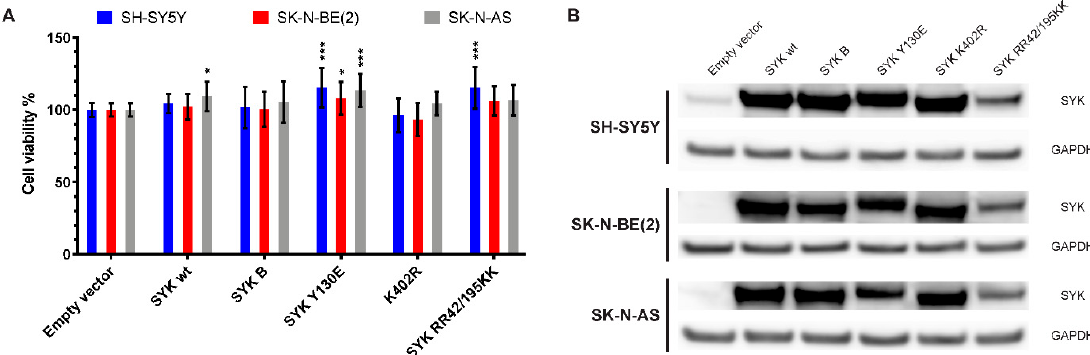
Figure 8. Transfection with an active SYK variant increases the cell viability of neuroblastoma cells independent of endogenous SYK levels. Cells were transfected with expression plasmids encoding different SYK variants and the cell viability was measured after 48 h by MTT assay ( A ). The empty vector control was set as 100% viable cells. Data are presented as mean ± SD from six independent experiments. Statistical comparisons were made using two-way ANOVA and a difference was observed between the SYK variants and between cell lines p < 0.001. The Dunnett’s multiple comparison test was used to evaluate the difference between empty vector and different SYK variants: * p < 0.05, *** p <0.001. Western blot analysis was used to evaluate the presence of SYK following